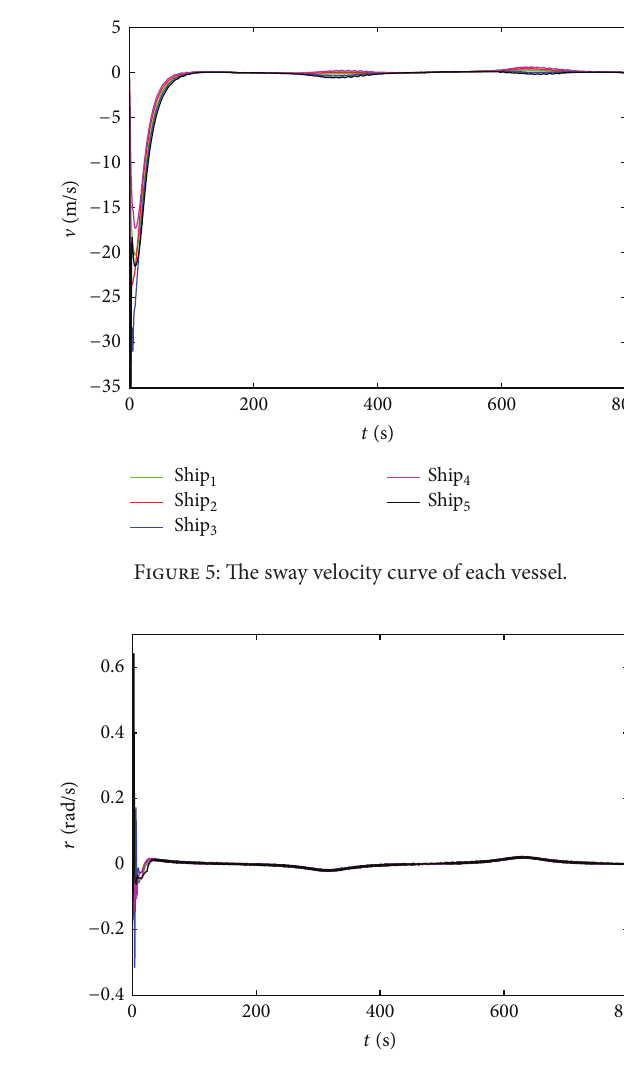
show the surge force, sway forces, and the heave torques applied to the vessels, respectively.